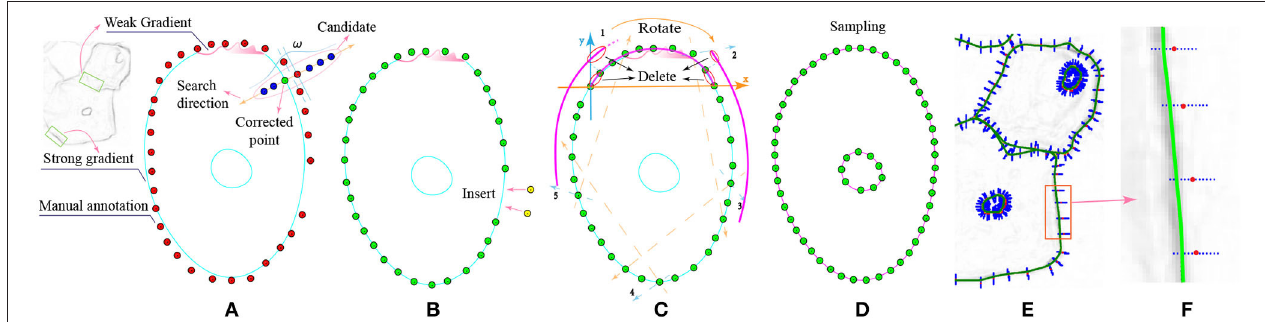
FIGURE 2 | The workflow of our LLPC algorithm. (A) Gradient-guided point correction (the red points Piecewise curve fitting (the purple curve); (D) Curve sampling; (E) The gradient image with the corrected edge label (the green edges); (F) Magnification of the gradient image. The whole label correction process is to generate the corrected edge (green edges) from original label points (red points) in (F) .